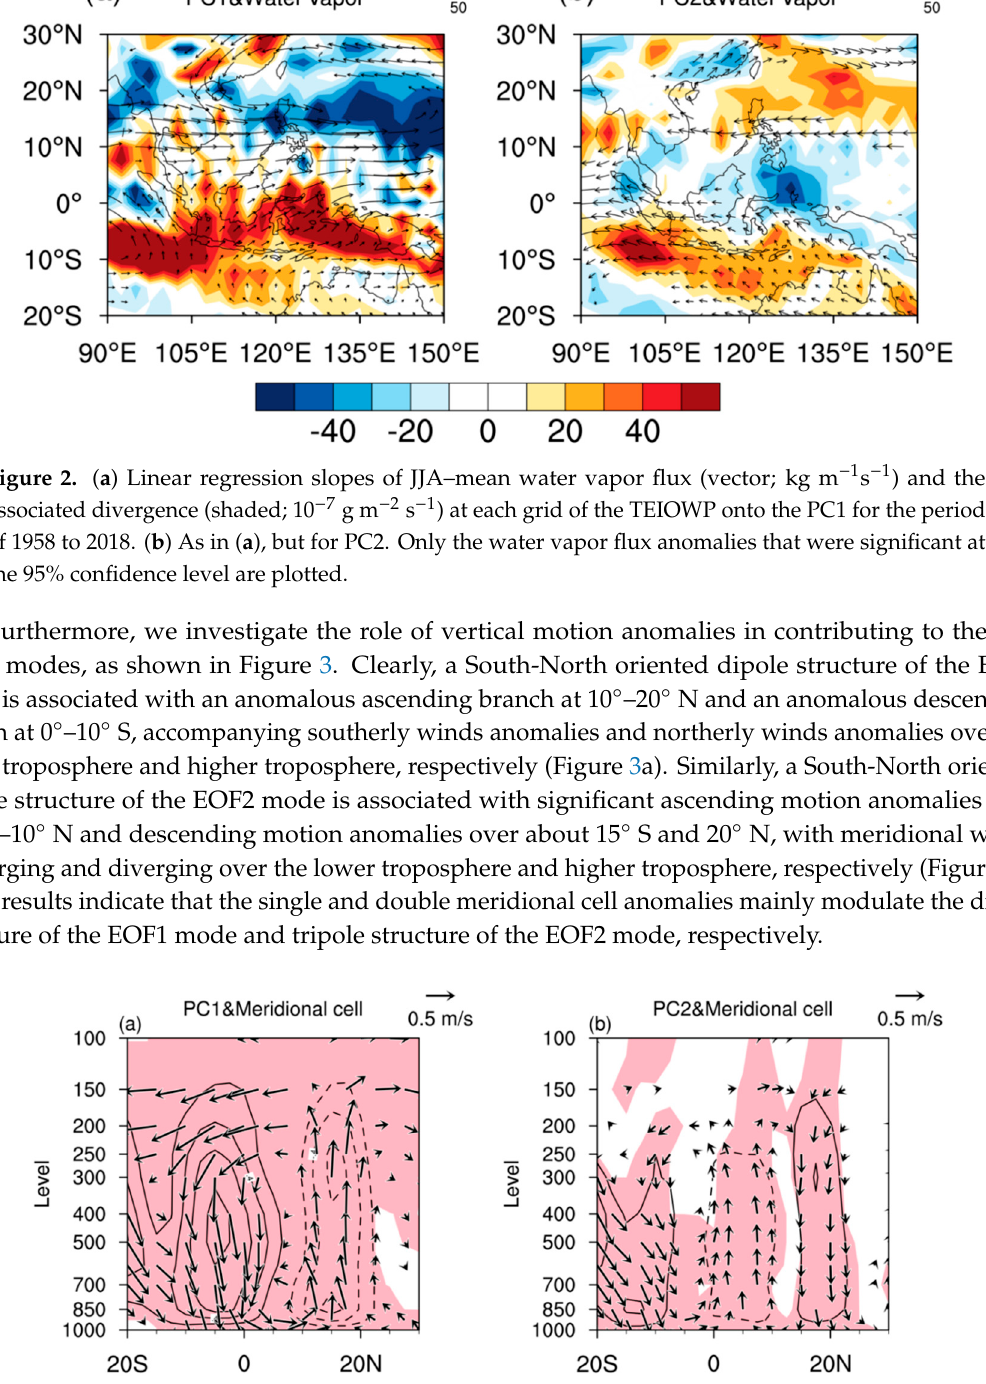
Figure 3. ( a ) Linear regression slopes of the latitude–height cross-section of the JJA–mean vertical velocity(contourinterval; 100 − 1 Pas − 1 ), wind(vector; meridionalcomponent, ms − 1 ; verticalcomponent, Pa s − 1 , multiplied by –100; the wind speeds less than 0.1 m s − 1 are not shown) averaged over 110 ◦ –140 ◦ E at each grid onto the PC1 for the period of 1958 to 2018. ( b ) As in ( a ), but for PC2. Note that the unit of the Y -axis is hPa. The shaded area denotes the wind anomalies exceeding the 95% confidence level; the zero contours are